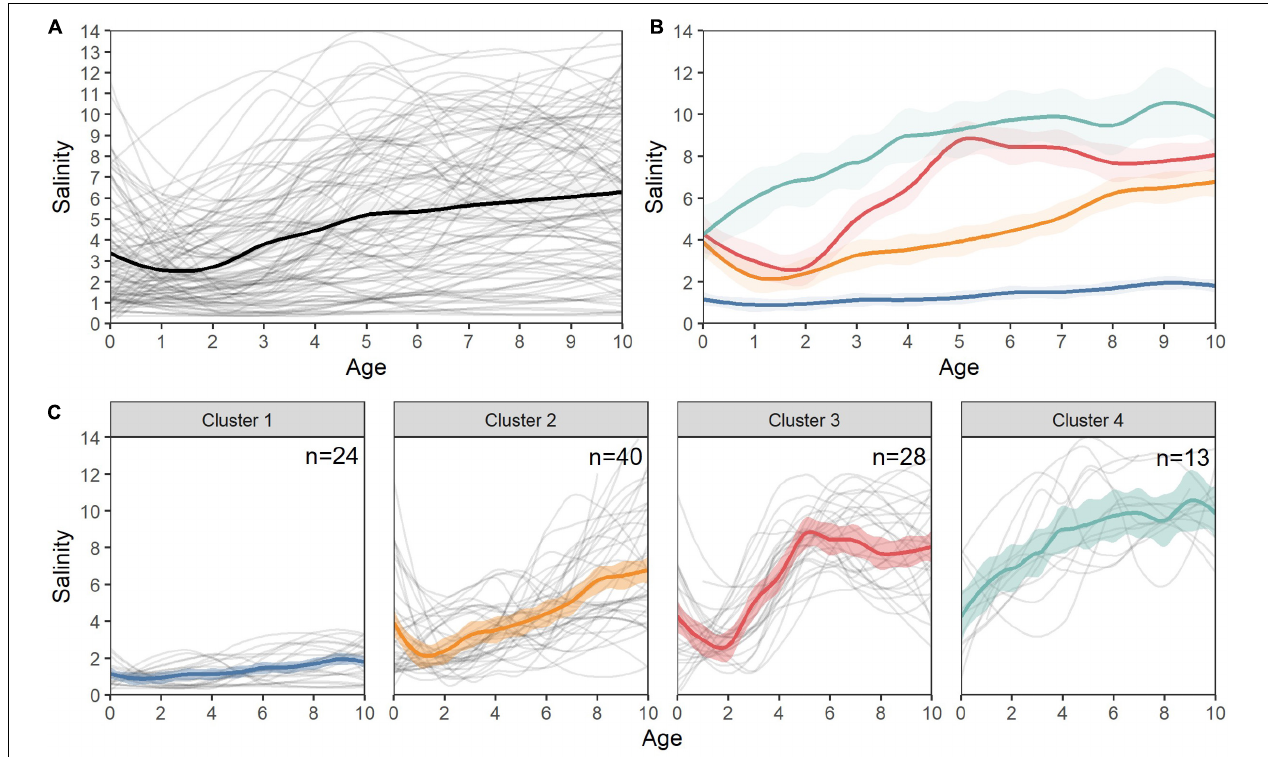
FIGURE 8 | Individual salinity chronologies and ontogenetic salinity clusters for San Francisco Estuary White Sturgeon. (A) Individual (gray) and mean (black) salinity splines for all fish, (B) overlayed mean loess smooths (span = 0.3) for each of the four statistical life history clusters, (C) overlayed mean loess smooths (span = 0.3) and individual (gray) salinity splines for all fish in each